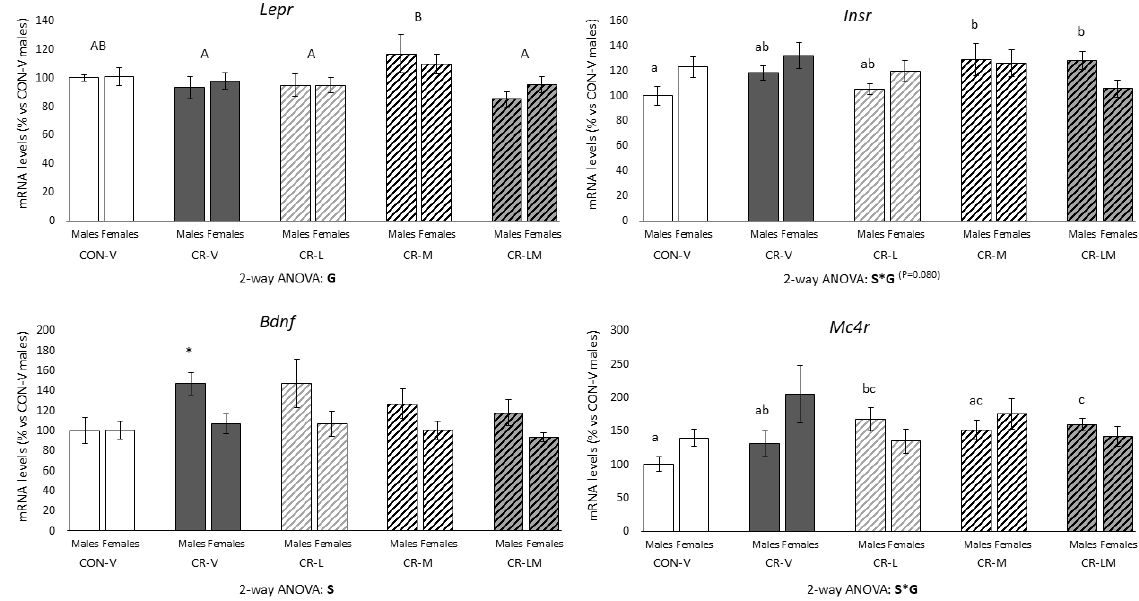
Figure 3. Hypothalamic expression levels of selected genes in 25-day-old male and female offspring of control (CON) and 25% gestational calorie-restricted (CR) dams. mRNA levels are expressed as a percentage of the value of CON-V male rats. Data are means ± s.e.m ( n = 8–10). Statistics: Two-way ANOVA was performed to assess the effects of sex and group (CON-V, CR-V, CR-L, CR-M, and CR-LM). One-way ANOVA was carried out to determine differences between groups in each sex separately when previous two-way ANOVA showed interactive effect between sex and group. ANOVA was followed by a least significant difference (LSD) post-hoc test. Mann–Whitney U test was used for single comparisons between groups. Symbols: S, effect of sex; G, effect of group; S*G, interactive effect between sex and group; A (cid:54) = B ( p < 0.05, two-way ANOVA); a (cid:54) = b (cid:54) = c ( p < 0.05, one-way ANOVA); *, different from their respective CON-V group ( p <